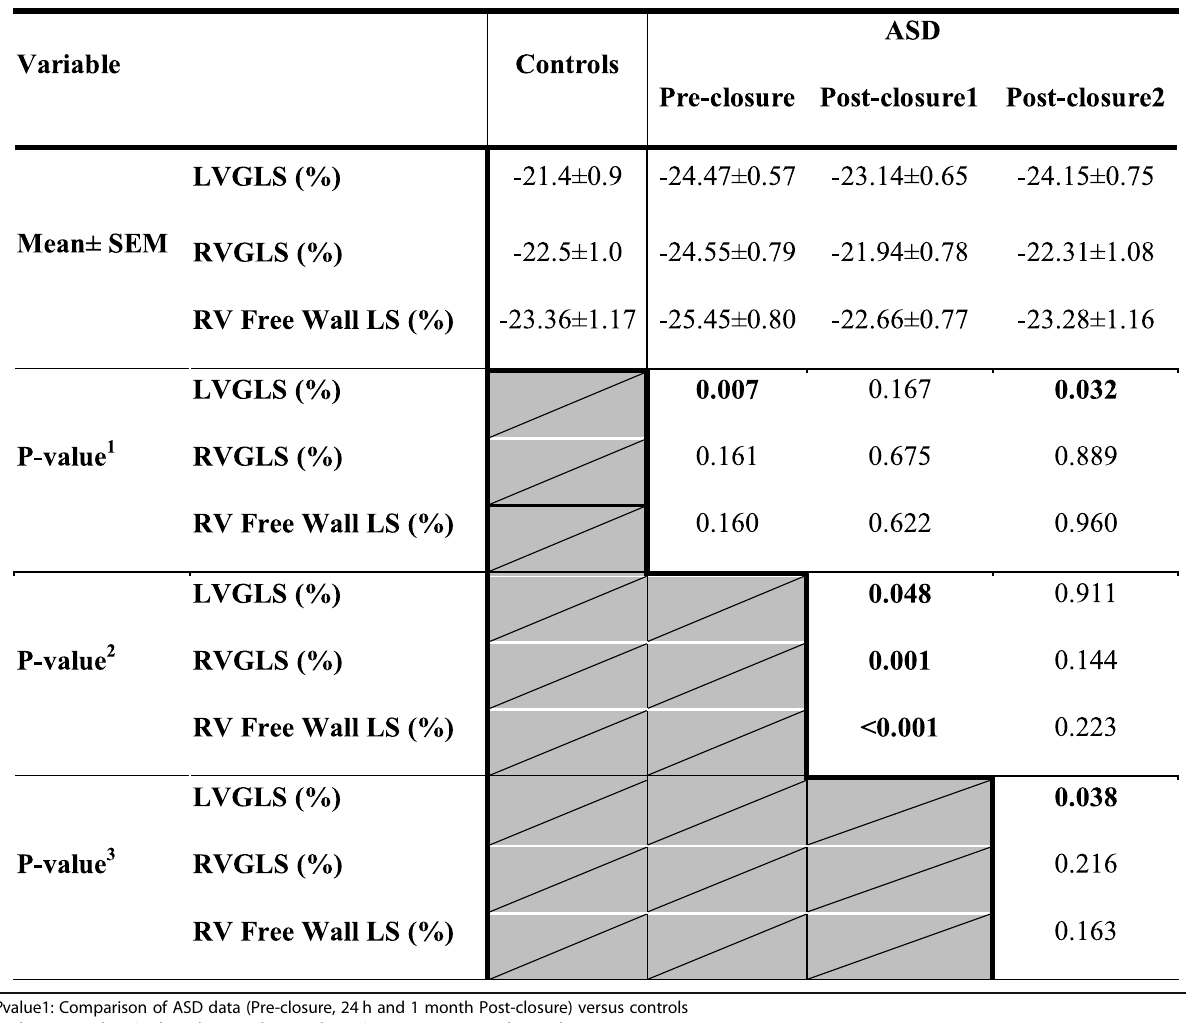
Table 4 Comparison between LV and RV GLSS and RV free wall LS before, after 24 h and 1 month of transcatheter ASD closure in relation to the